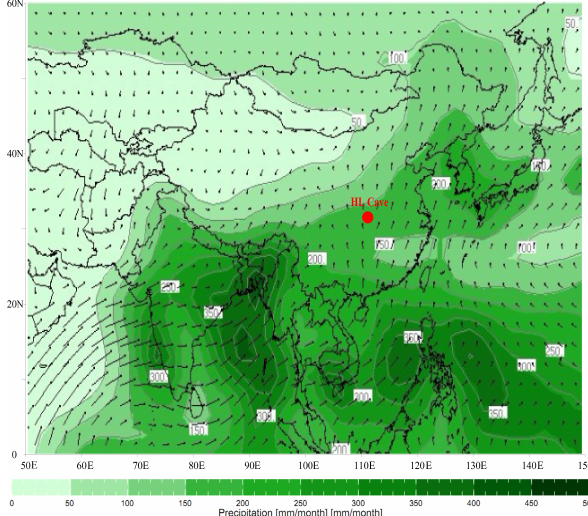
Fig. 1. Global mean July precipitation (mmmonth − 1 ) within the longitudinal and latitudinal ranges of 50 ◦ E–150 ◦ E, 0 ◦ N–60 ◦ N, including the site of Heilong Cave (HL, Central China, 31 ◦ 40 0 N, 110 ◦ 26 0 E, this study). Image from the Website: http://iridl.ldeo. columbia.edu/. The numbers in the figure show the monthly rainfall. Climatological wind vectors for the 925 hPa pressure level indicate wind direction with speed proportional to the length of the vectors. The data source is NCEP, Climate Prediction Center